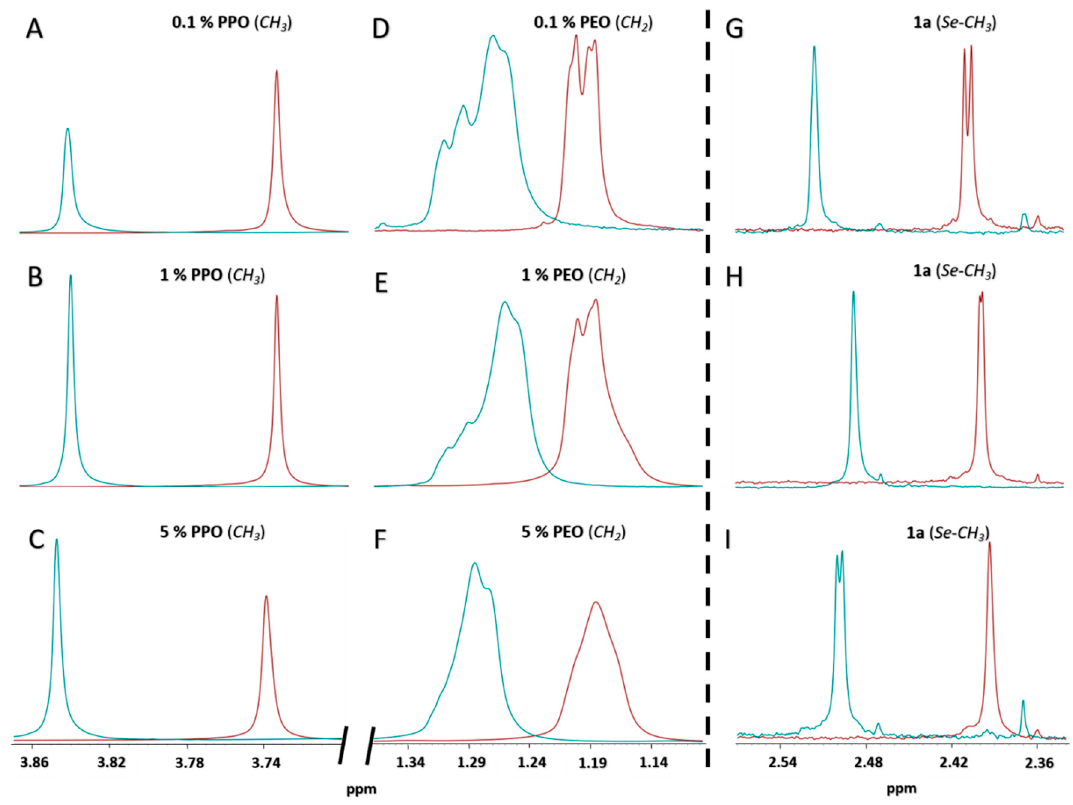
Figure 8. Expanded 1 H-NMR spectra of Pluronic F127 solutions (0.1%, 1% and 5% ( w / v )) showing the signal of methyl (CH 3 ) groups of the PPO ( A – C ) and methylene (CH 2 ) groups of the PEO ( D – F ). Expanded 1 H-NMR spectra of 1a in presence of 0.1%, 1% and 5% ( w / v ) Pluronic F127 solutions showing methylseleno (Se-CH 3 ) group signal for 1a ( G – I , respectively), at 27 ◦ C (red lines) and 37 ◦ C (blue lines). In the presence of drug, changes in the resonances of 1a reflect the di ff erent magnetic environments. ◦ The expanded 1 H-NMR spectrum of 1a with 1% ( w / v ) F127 at 37 C (micelles fully formed) showed an intense singlet peak at 2.5 ppm, assigned to the protons of the methylseleno (Se-CH 3 ) group of